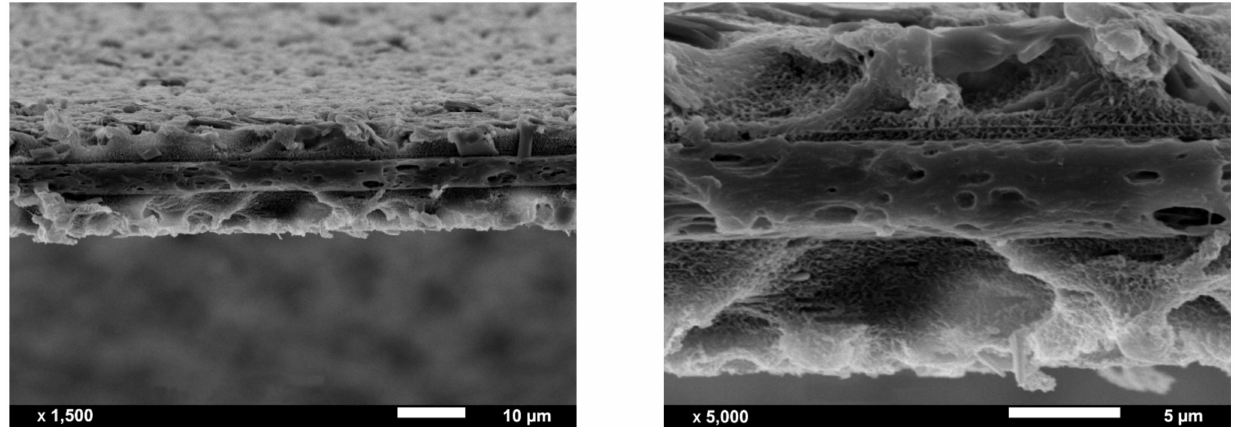
Figure 3. Scanning electron microscope (SEM) micrographs of the cross-section of an etched multilayer membrane. Outer layers consist of polypropylene filled with 10 wt% talc